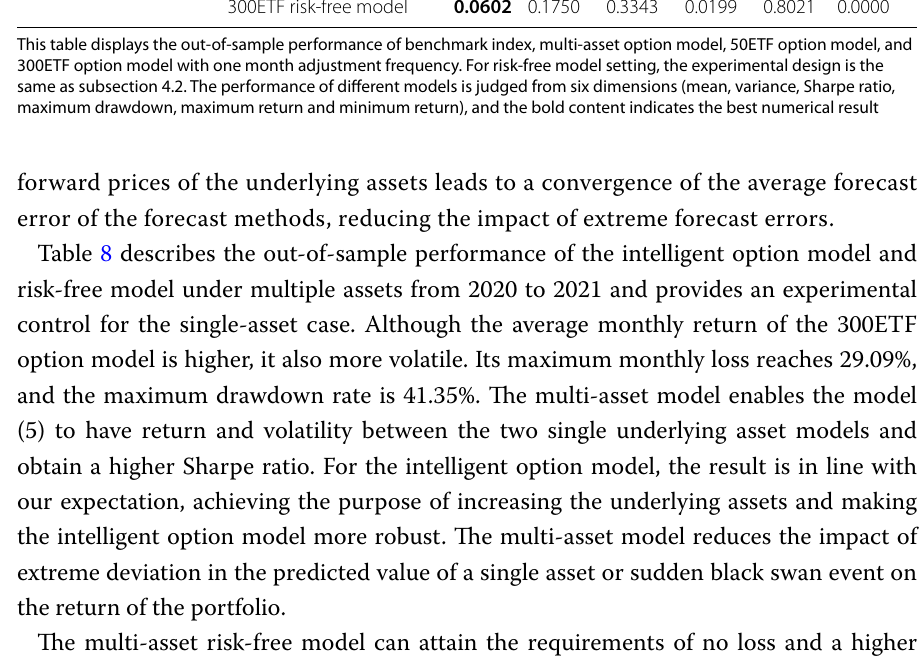
This table displays the out-of-sample performance of benchmark index, multi-asset option model, 50ETF option model, and 300ETF option model with one month adjustment frequency. For risk-free model setting, the experimental design is the same as subsection 4.2. The performance of different models is judged from six dimensions (mean, variance, Sharpe ratio, maximum drawdown, maximum return and minimum return), and the bold content indicates the best numerical